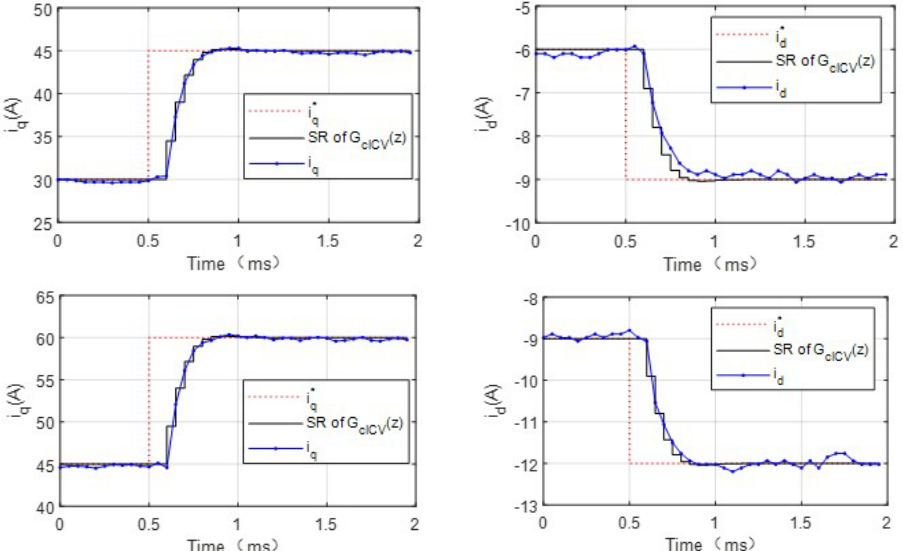
Figure 17. Experiment result of complex vector controller based on flux-linkage data ( k = 0.3) of the locked saturated machine.